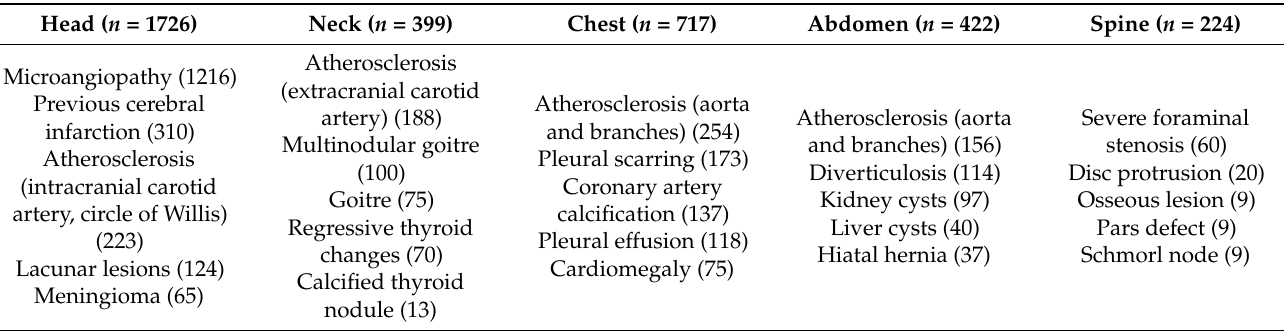
Figure 3. Distribution of incidental finding (IF) categories per age group. Table 4. Top 5 incidental findings per